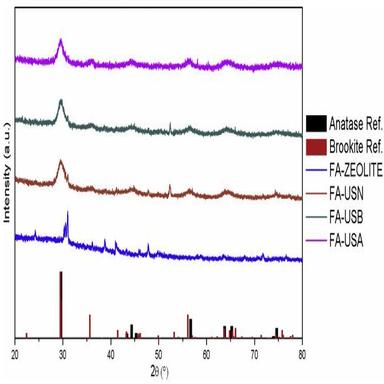
XRD spectra of anatase (black) and brookite (red) TiO2 (reference: Pearson's Crystal Data), FA-zeolite (blue), sample FA-USN (orange), FA-USB (dark cyan) and FA-USA (magenta). (For interpretation of the references to colour in this figure legend, the reader is referred to the Web version of this article.)